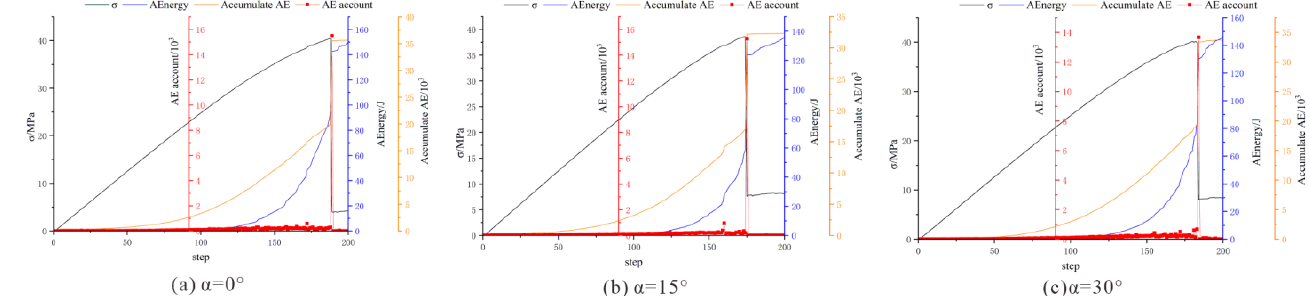
Figure 11. Relationship between loading stress, AE account, Accumulative AE and AEnergy and step number of coal under low dip angle.